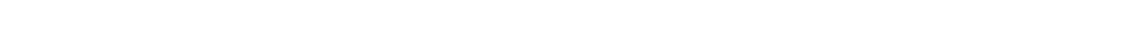
Frontiers in Oncology | Radiation